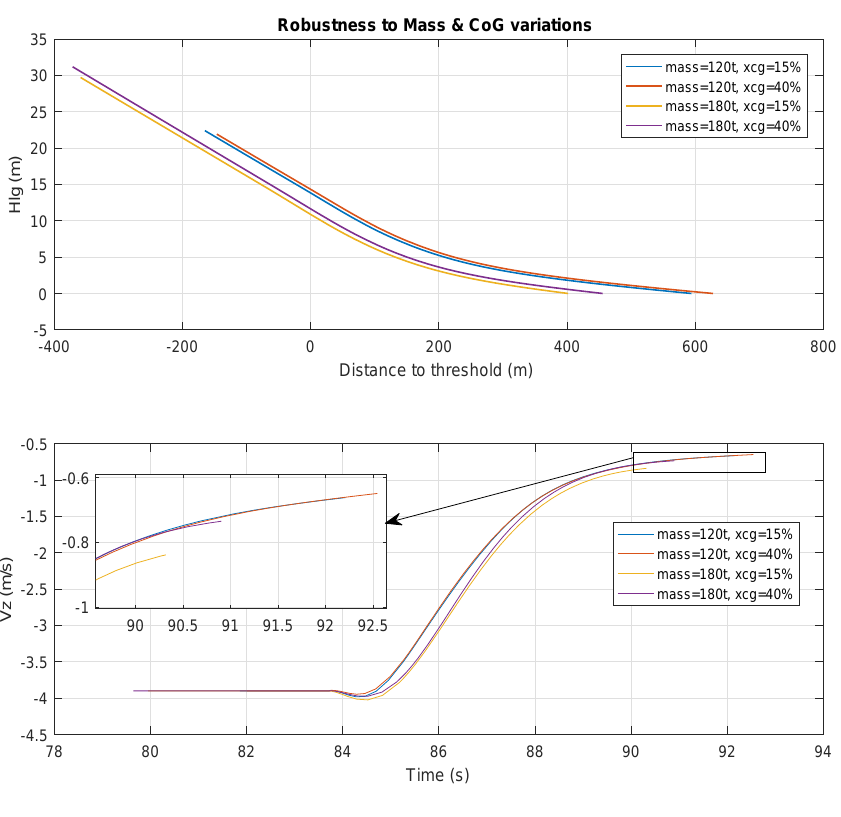
Figure 11. Robustness to mass and center-of-gravity